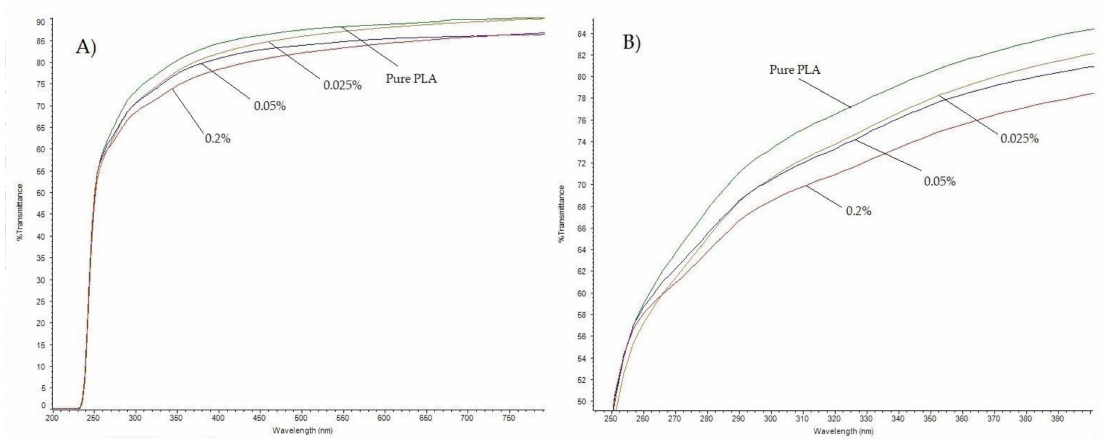
Figure 2. The UV-Vis spectra of pure PLA and PLA/melanin modified films at 200–800 nm ( A ) and 250–400 nm ( B